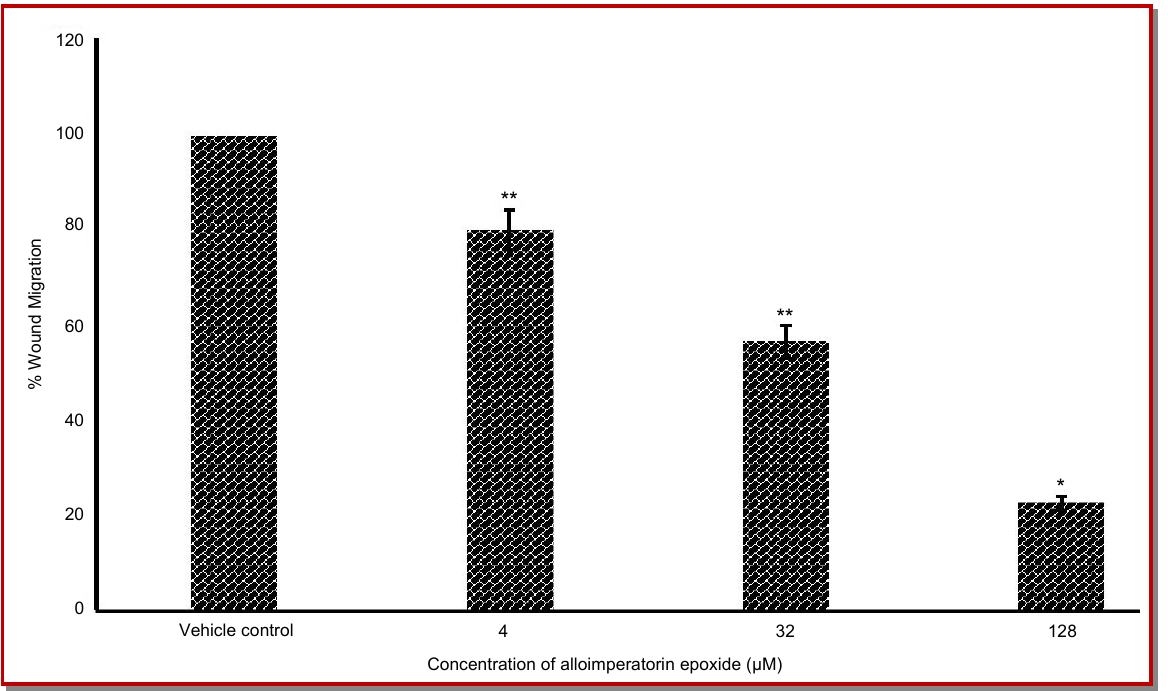
Figure 5: Alloimperatorin epoxide inhibits HL-60 cancer cell migration. The cells were treated with 0, 4, 32 and 128 µM dose of alloimperatorin epoxide for 48 hours and photographs were captured using inverted light microscope. The number of migrated cells were calculated and shown graphically as above. *p<0.05, **p<0.01, vs 0 µM